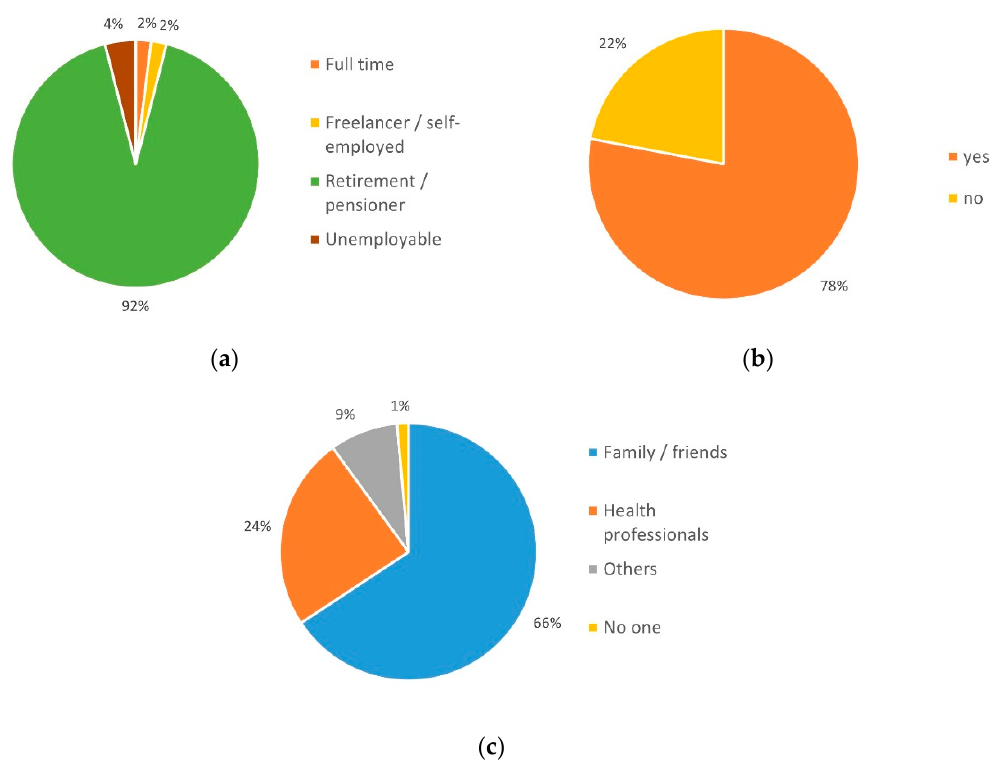
Figure 2. Health status: ( a ) current condition (self-assessment), ( b ) 6-minute-walk-distance. It turned out that 78% ( n = 39) of the VAD patients were able to access support at home (Figure 3b). In 66% ( n = 33) of the cases, family members and/or friends were the supporters, 24% ( n = 12) had professional help, and in 10% ( n = 5) of the cases, patients were either on their own or dependent on sporadic supporters (Figure 3c) (Multiple answers were possible in answering this question.)